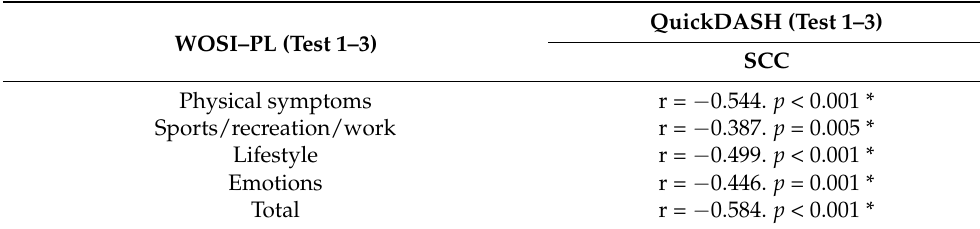
Table 7. Spearman’s correlation coefficients (SCC) between changes (test 1–3) in all domains and Total score of the WOSI PL and changes in the QuickDASH ( n =